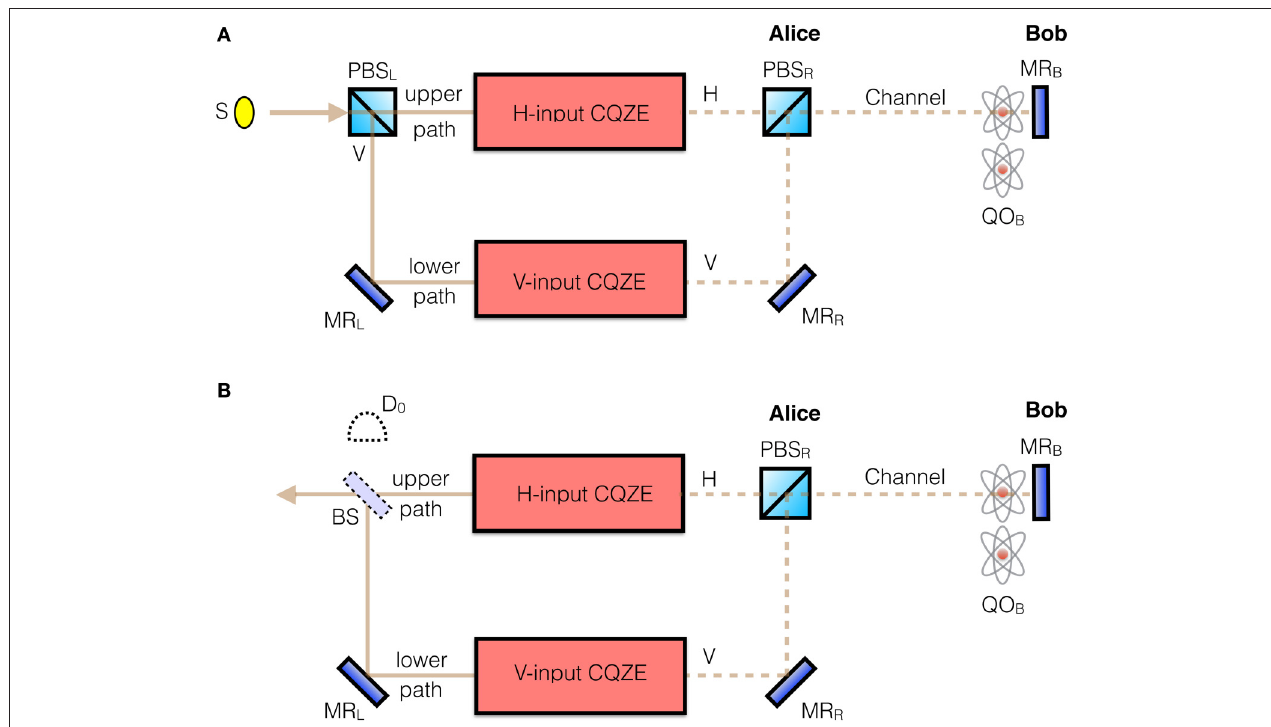
H V , while β | i + | i